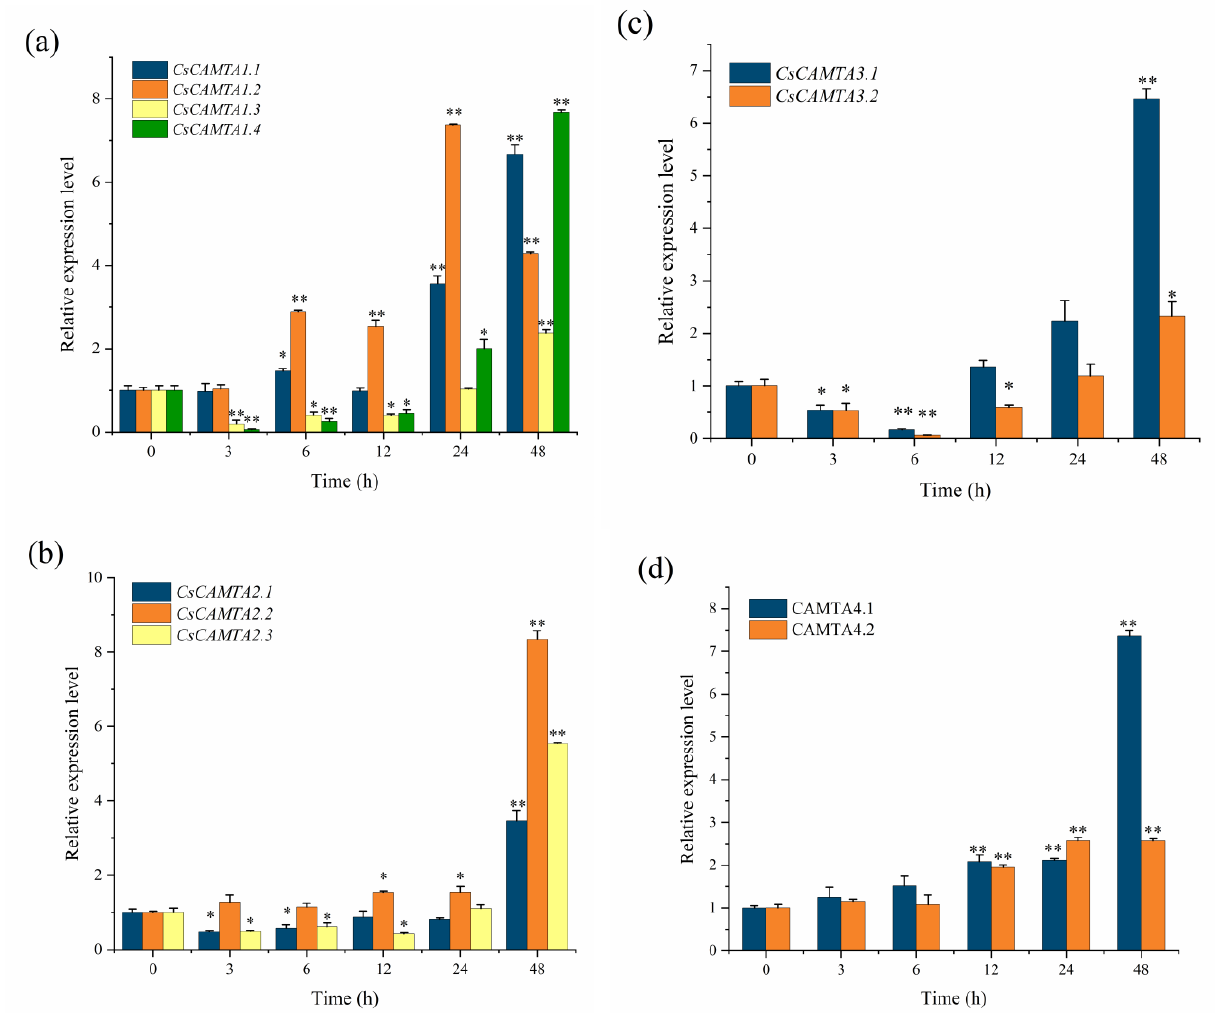
Figure 8. Expression analysis of alternative splicing form of CsCAMTA genes in leaves under salt stress. ( a ) CsCAMTA1 ; ( b ) CsCAMTA2 ; ( c ) CsCAMTA3 ; ( d ) CsCAMTA4 . Error bars represent the standard deviation of the three biological replicates. The asterisk (*) indicates that the expression level of the stress group is significantly different from that of the control group (* p <0.05, ** p <0.01, one-way ANOVA, Tukey test).